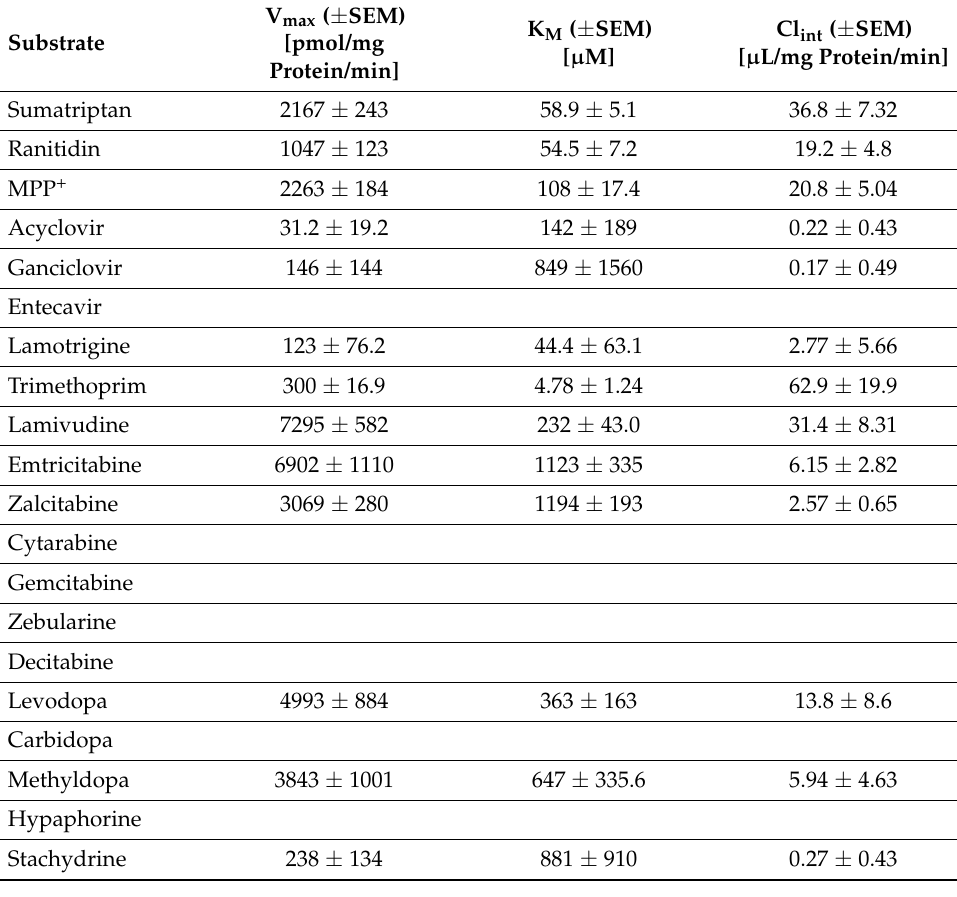
Table 2. Kinetic parameters of substrates OCT1.